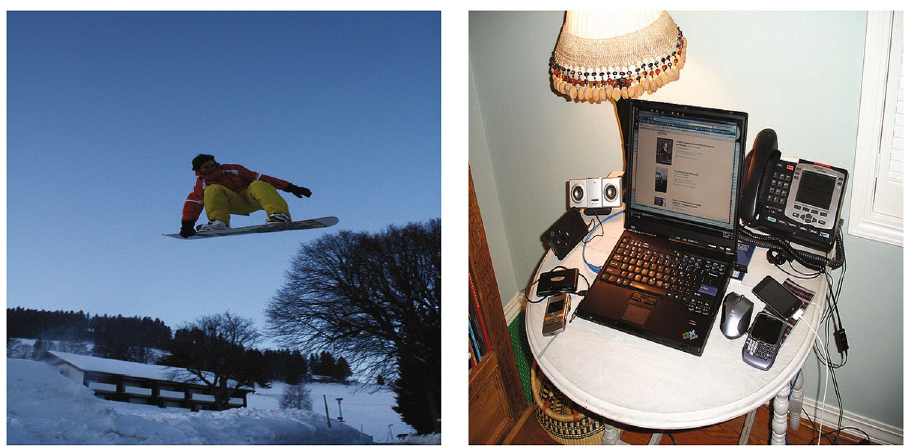
Fig. 1 Two examples from VQA v2 dataset. Simply stitch- ing or fusing two modal features can make the model misun- derstand the fused features and fail to answer the question accurately. Therefore, we need to strengthen the information interaction between modalities. In addition, critical information within the modality also needs to be